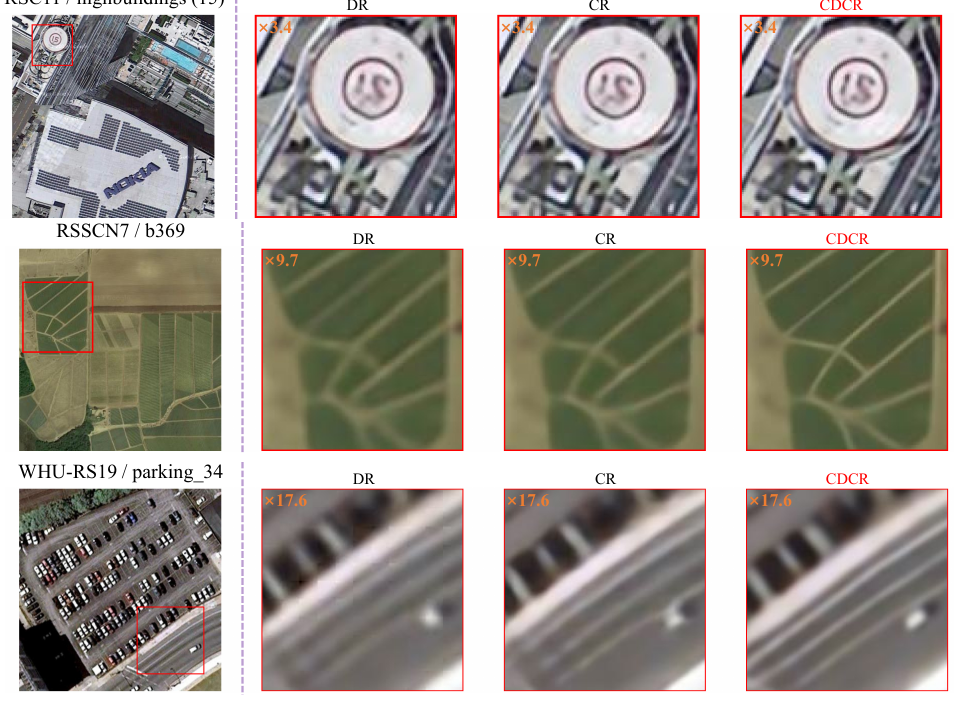
Figure 2. Visual comparison between DR, CR, and CDCR at scale factors of 3.4, 9.7, and 17.6,